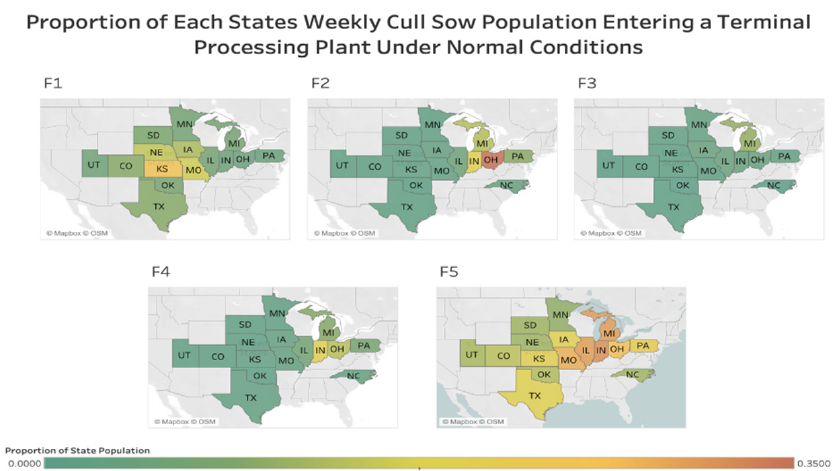
Figure 1. The proportion of a state’s cull sow population that enters each terminal processing facility F1–F5, under normal operating conditions. Each pane labeled F1, F2, F3, F4, F5 represents a different processing facility.